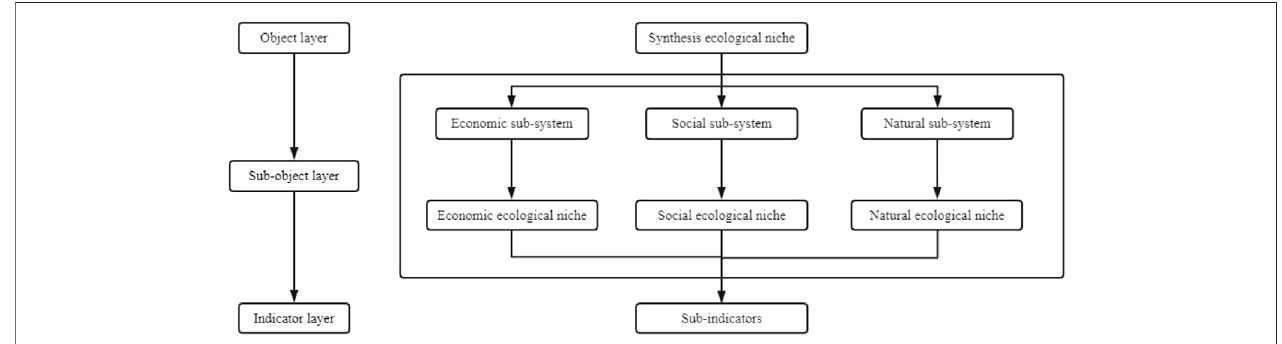
FIGURE 3 | Structure of the indicator system used to assess complex ecosystems. The ecological niche assessment indicator system comprises three levels (objectives, sub-objectives, and guidelines) with four indicators. The fi gure represents the indicators mentioned in Table 1